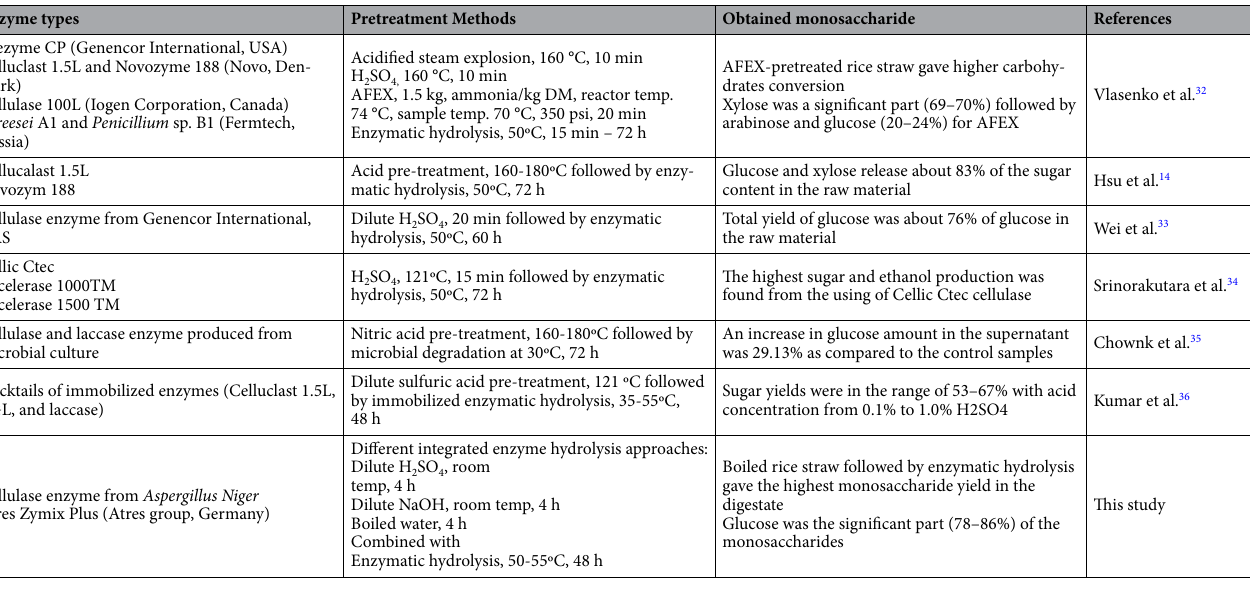
Table 3. Comparison of pre-treatment methods, enzyme uses, and monosaccharide production.